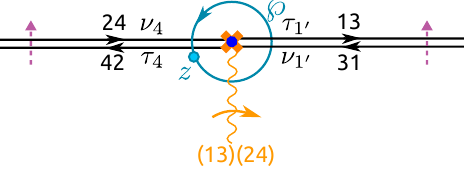
Figure 6 . The loop around the [2 ; 2] puncture z 3 = ! 2 for which we compute the framed 2d-4d BPS